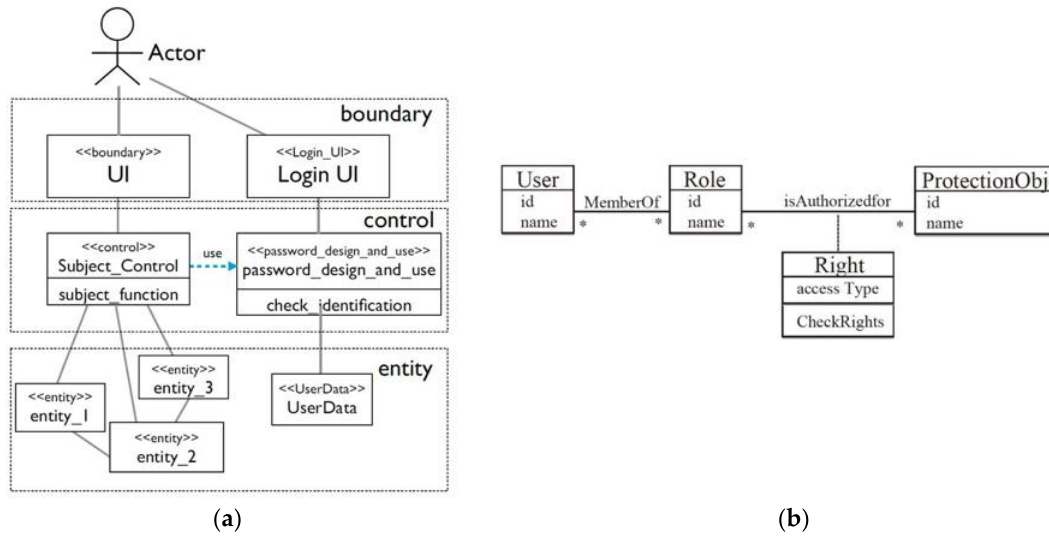
Figure 1. ( a ) Structure of a security design pattern (Password Design and Use pattern) and ( b ) structure of a security design pattern (Role-based Access Control pattern ).